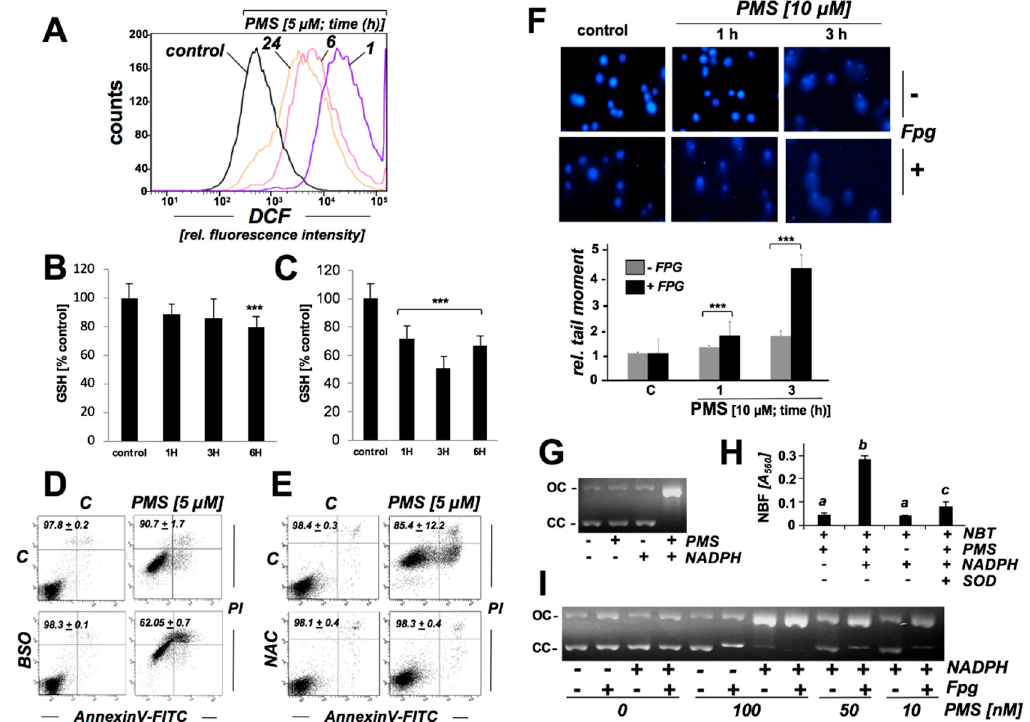
Figure 5. PMS exposure induces redox dysregulation with glutathione depletion and oxidative impairment of genomic integrity in human A375 malignant melanoma cells, a genotoxic effect that can also be observed in an in vitro plasmid cleavage assay. ( A ) Analysis of oxidative stress in PMS-exposed A375 cells (10 µ M, ≤ 24 h) as monitored by flow cytometric detection of DCF fluorescence. One set of histograms representative of three repeats is shown. ( B , C ) Time course ( ≤ 6 h) of PMS-modulation of intracellular reduced glutathione content in A375 cells (panel B : 1 µ M; panel C : 10 µ M), normalized to cell number (mean ± SD, n ≥ 3; *** p < 0.001). ( D , E ) After preincubation (24 h) with BSO (1 mM, panel C ) or NAC (10 mM, panel D ), PMS-induced (5 µ M, 24 h) A375 cell death was assessed by flow cytometric analysis of AV / PI-stained cells (mean ± SD, n ≥ 3). ( F ) Fpg-enhanced Comet assay assessing cellular genotoxic stress (40 fold magnification; PMS: 10 µ M; (analysis post treatment: ≤ 3 h); bar graph: tail moment analysis ( n ≥ 100 per group; mean ± S.E.M; *** p < 0.001). ( G ) PMS-induced Φ X174-plasmid cleavage in vitro ( OC : open circular; CC closed circular; PMS: 1 µ M; NADPH: 200 µ M; 3 h reaction time). ( H ) PMS-induced superoxide production as assessed by NBT reduction performed in the presence or absence of SOD (3000 µ / mL; n = 3). NBF was detected photometrically (A 560 nm). ( I ) PMS dose response of Fpg-enhancement of Φ X174-plasmid cleavage in vitro ( OC : open circular; CC closed circular; PMS: ≤ 100 nM; NADPH: 200 µ M; 3 h reaction time), indicative of oxidative DNA lesions induced by NADPH / PMS